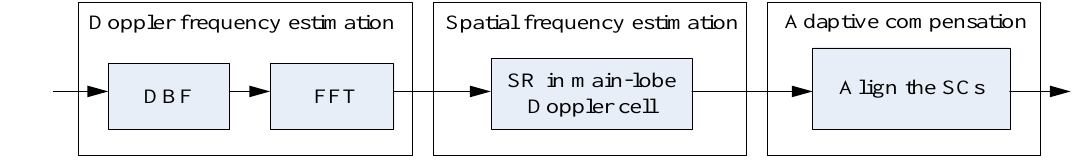
Figure 3. The EAADC